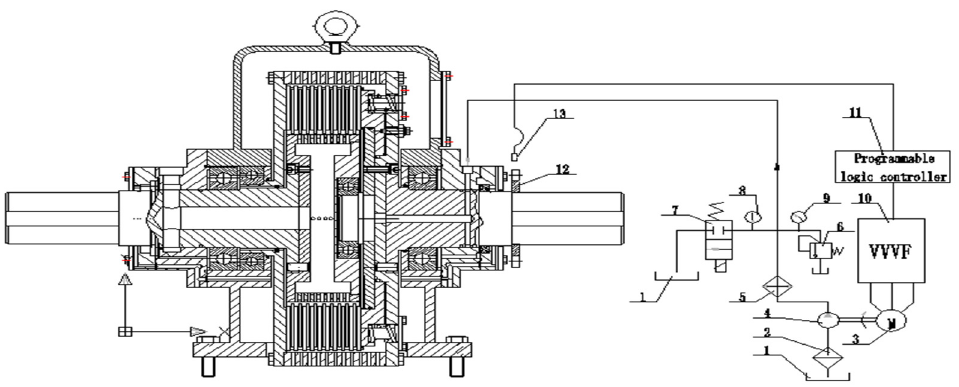
Figure 3. New hydraulic pump control system for HVC. 1. Hydraulic oil tank; 2. filter; 3. gear pump motor; 4. gear pump; 5. chiller; 6. safety valve; 7. electromagnetic valve; 8. thermometer; 9. manometer; 10. frequency converter; 11. PLC; 12. measuring speed gear; 13. speed sensor.